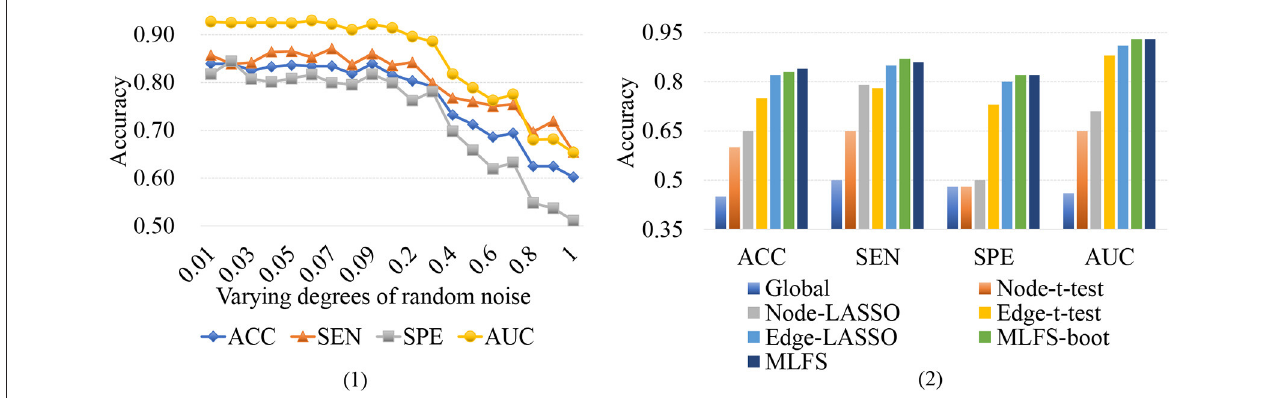
FIGURE 12 | (1) Results achieved by the proposed method with varying degrees of FBN random noise in lMCI vs. eMCI classification. (2) Results achieved by the proposed MLFS-boot method, the MLFS methods, and other five competing methods in lMCI vs. eMCI classification.